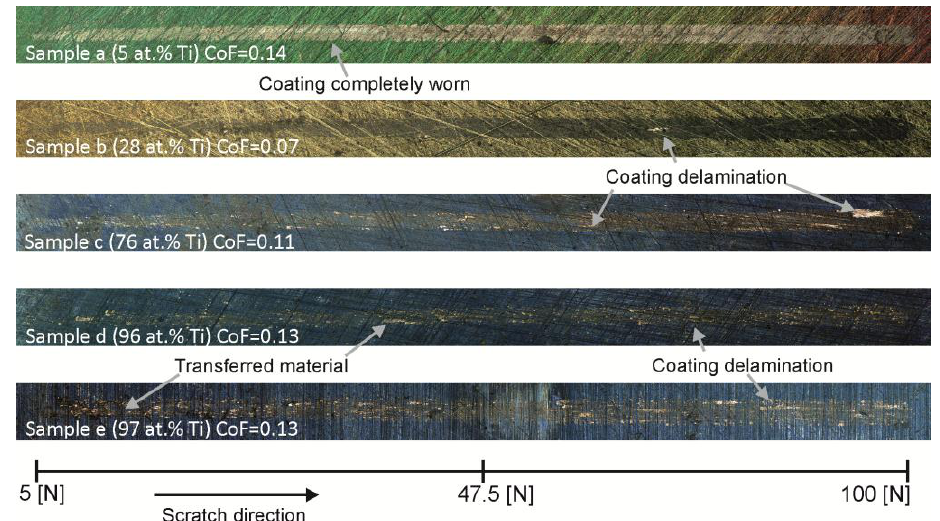
Figure 5. Optical microscope images of scratches after ball on flat frictional test with Cr ball for progressive increasing load 5–100 N.